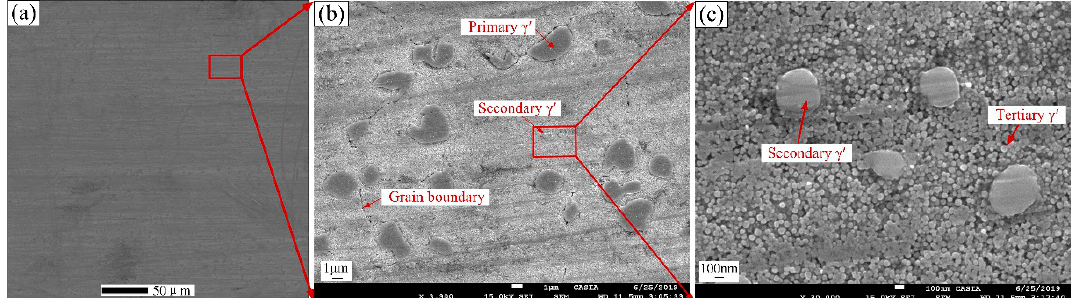
Figure 3. SEM image of initial γ’ morphology; ( a ) large-area SEM image of 32 K × 32 K pixels; ( b ) partly enlarged view of ( a ); ( c ) partly enlarged view of ( b ).